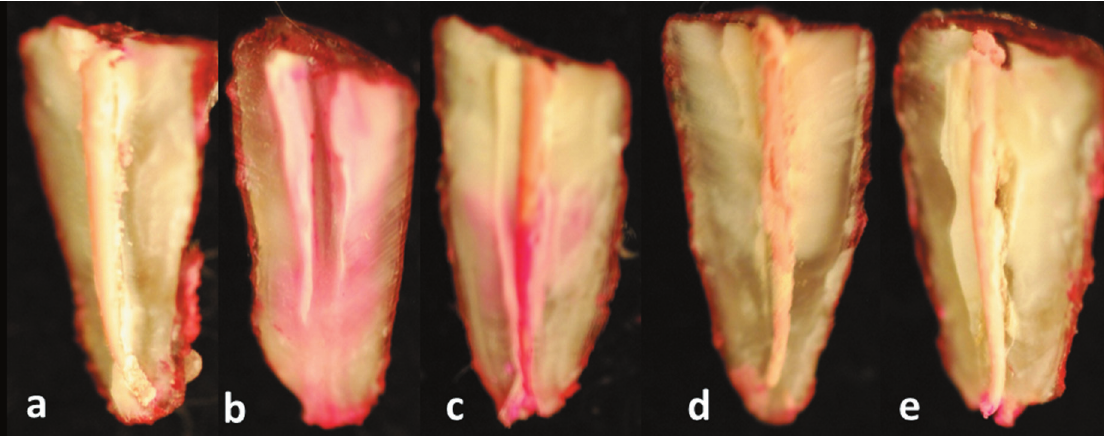
Figure 1- Leakage pattern according to the groups. a) Negative Control, observe absence of leakage (reddish staining); b) Positive Control, observe leakage along the walls from apical to the cervical root third; c) Endo CPM-Sealer ® , observe leakage along the walls from the apical to the middle root third; d) MTA Fillapex ® , observe absence of staining; e) Sealapex ® , observe leakage only on the apical portion of the mater cone Table 1- Comparison of mean dye leakage values (mm) and standard deviations (SD) of the endodontic sealers Materials n Mean±SD (mm) Fillapex ® 30 0.80±0.61 a Endo-CPM-Sealer ® 30 2.44±1.00 b Sealapex ® 30 1.22±0.53 a *Same letters indicate no statistical difference among the groups